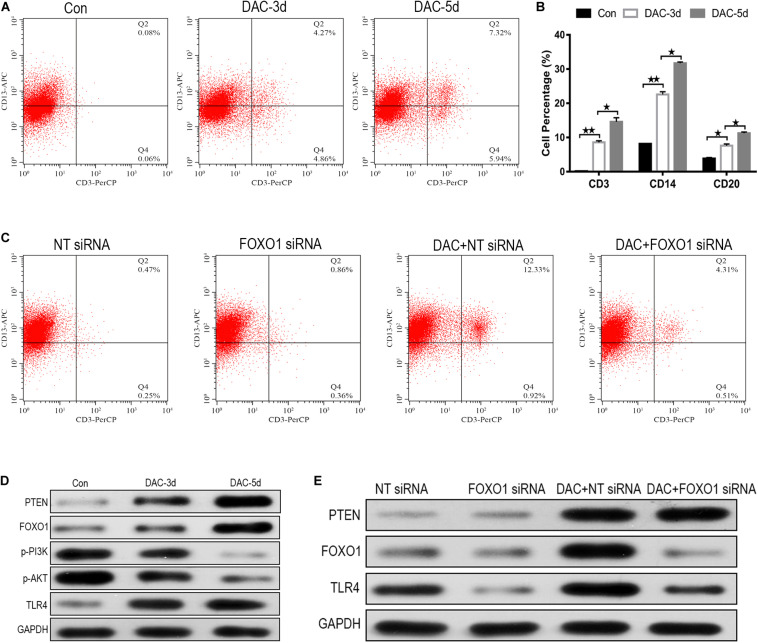
FOXO1 contributes to DAC-induced MDS-L cell differentiation. CD3 expression on CD13 was significantly induced in MDS-L cells treated with DAC for different action times (A). The percentage of CD13 expressing CD3, CD14, and CD20 antigen increased following DAC treatment (B). Surface CD3 and CD13 expression had clearly no change between FOXO1 siRNA and negative control siRNA in MDS-L cells, while surface CD3 expression was impaired in FOXO1 siRNA compared with negative control siRNA in DAC-treated MDS-L cells (C). Western blot showed that PTEN, FOXO1, and TLR4 in MDS-L cells increased with p-PI3K and p-AKT protein decreasing after DAC treatment (D). FOXO1 silencing had no obviously influence on PTEN, but decreased the expression of TLR4 that was observed following DAC treatment (E). **Student’s t-test P < 0.01 and *P < 0.05.